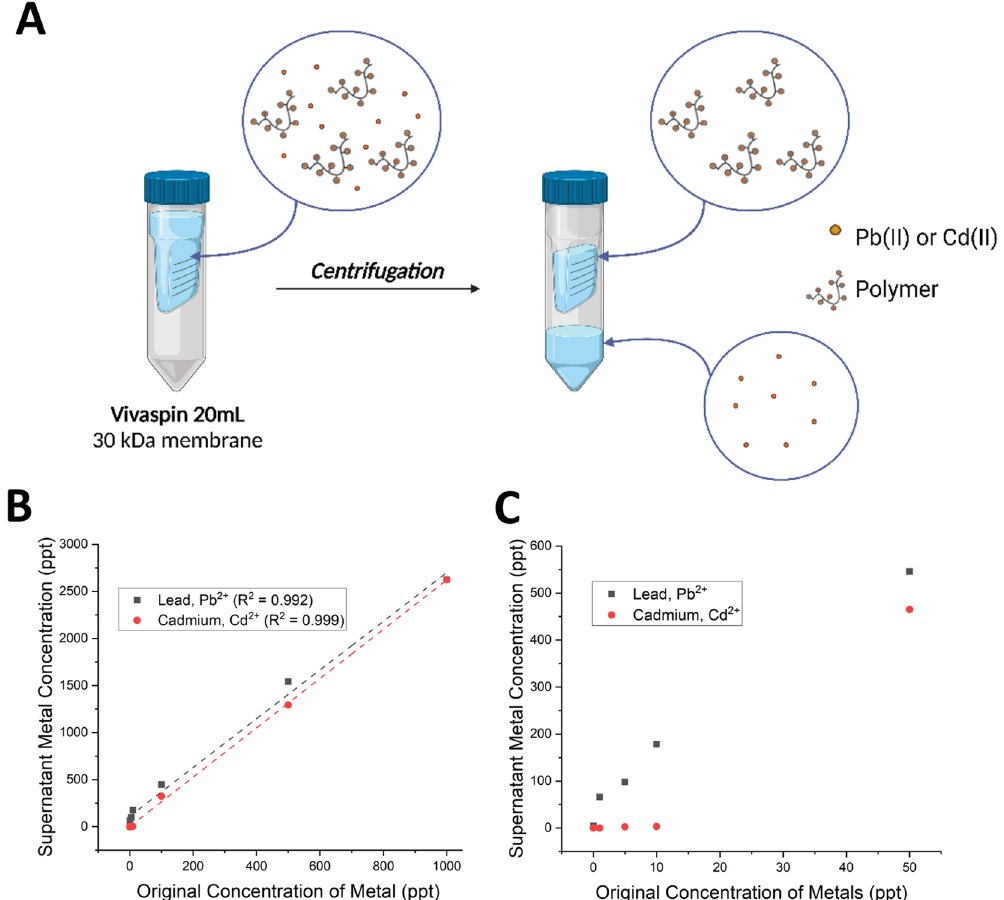
Figure 2. ( A ) Scheme of Vivaspin experiment. The metals that are not chelated pass through the membrane, while chelated metals are bound to the polymer that cannot pass through the membrane. Image created